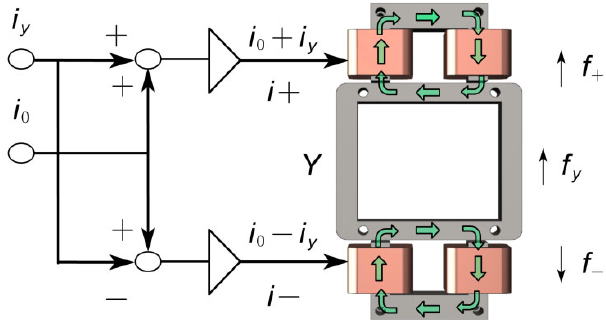
Figure 3. Magnetic flux path through the U ‐ core electromagnet.